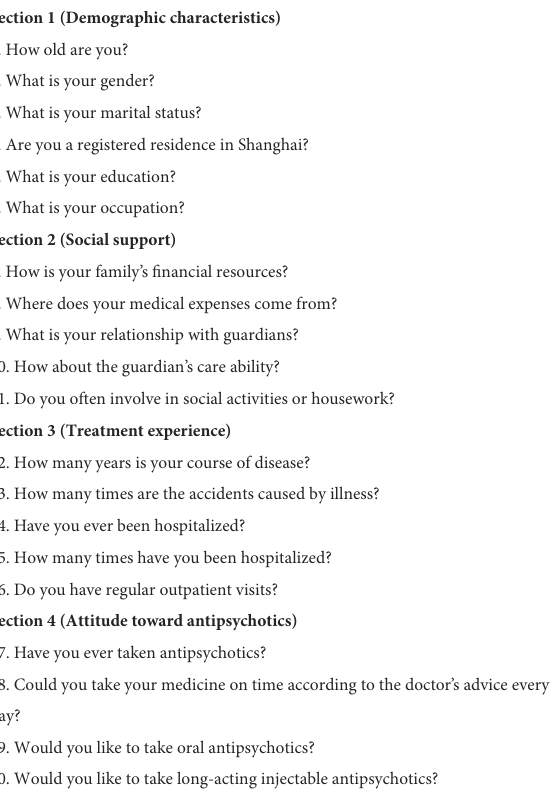
TABLE 1 Attitude and status toward treatment of community patients with schizophrenia questionnaire (AST-CSQ).